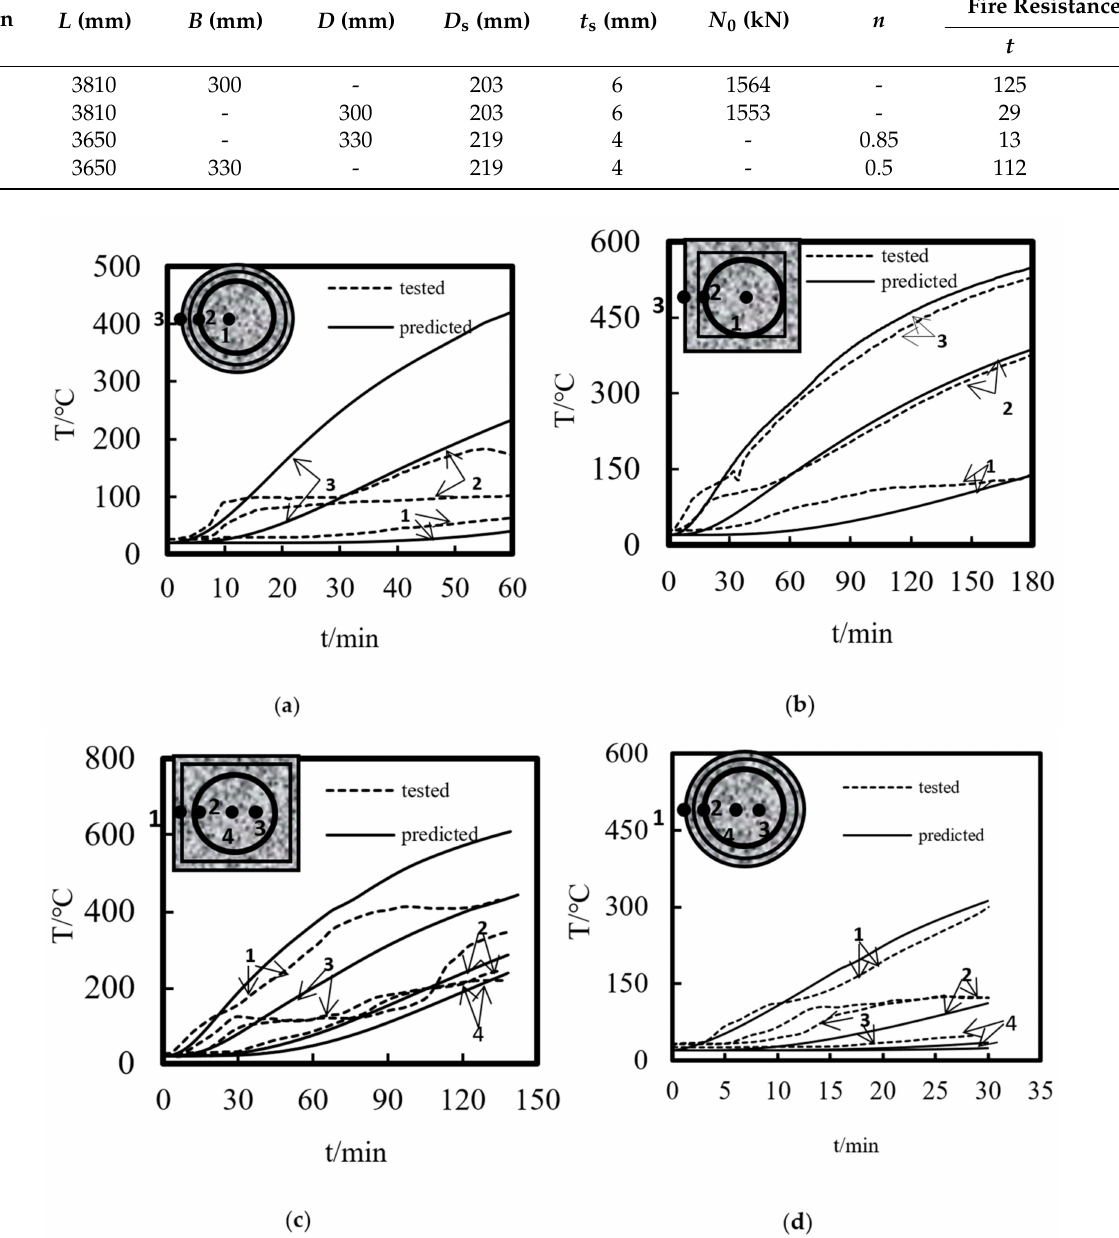
Figure 4. The comparison of temperature versus time curves of the ST-RC columns ( a ) C4; ( b ) S4; ( c ) SZ1-1; ( d )